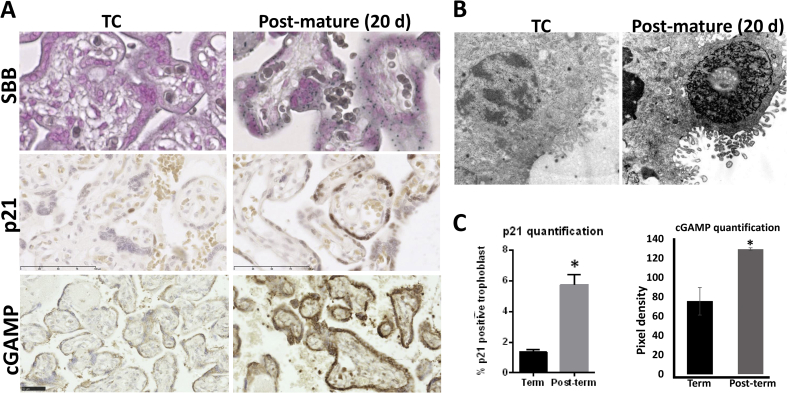
Evidence of senescence in post-mature placentas. Archival sections from term healthy placentas (N = 5) and post-mature placentas (delivered 7–20 d after due date, N = 6) were stained with Sudan-Black-B (SBB) to detect lipofuscin, which is an aggregate of oxidised proteins, lipids and metals, known to accumulate in aged tissues (A), with p21 (A, C) or cGAMP (A, C). Compared to term controls, which only showed sporadic SBB staining, the post-mature placentas showed abundant cytoplasmic staining with SBB (A). B) Archival EM blocks of control and post-mature placentas were examined. Images show dense heterochromatin in a placenta that was delivered 20 days after the due delivery date. C) The number of p21 positive trophoblast nuclei was quantified and expressed as a percentage of the total number of trophoblast nuclei counted (total number of trophoblast nuclei was counted in five fields of view per sample at ×20 magnification, using Image J). Similarly, the staining intensity of the cytoplasmic cGAMP staining was quantified in term and post-term placentas using Image J. * Significant differences (P < 0.05, t-test).